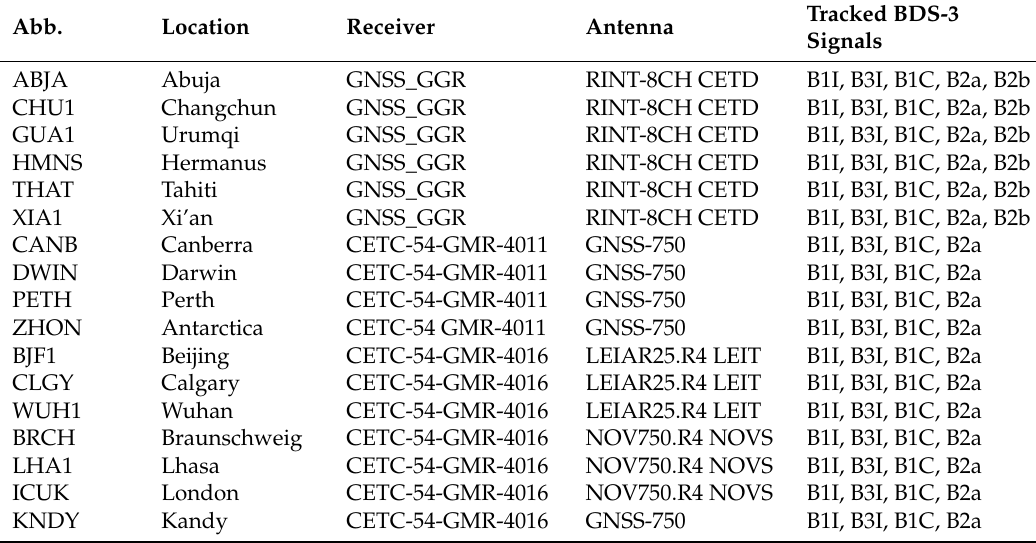
Figure 1. Distribution of selected stations in the iGMAS network. Table 3. Configuration of selected iGMAS